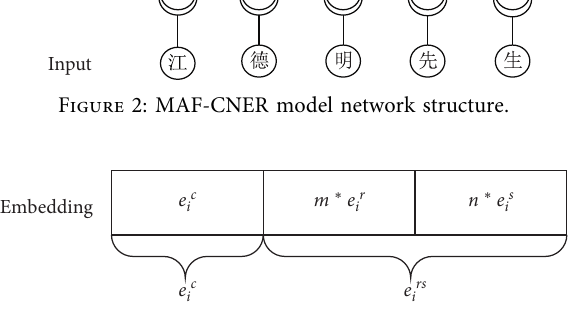
Figure 3: Characters, strokes, and radical vector